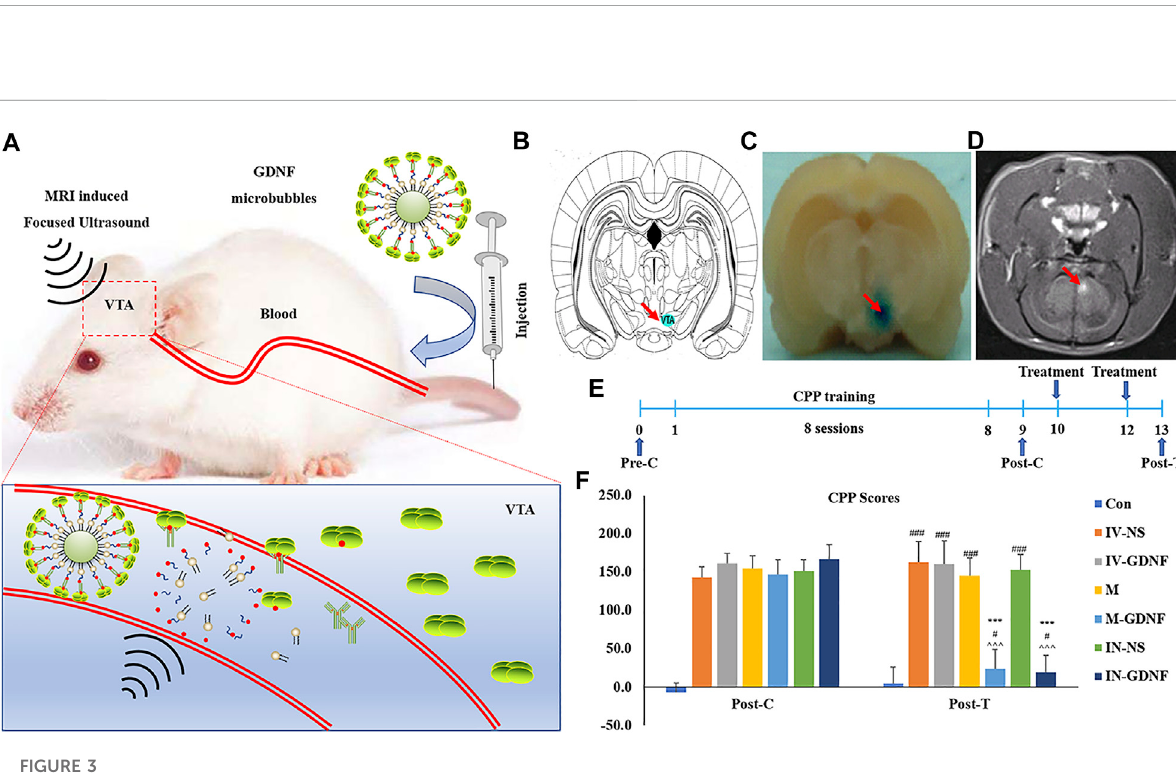
focused ultrasound successfully opened the BBB in the VTA region using the previously measured optimal parameter conditions, which was further con fi rmed by MRI imaging (Figure 3D). The CPP training and treatment procedures for